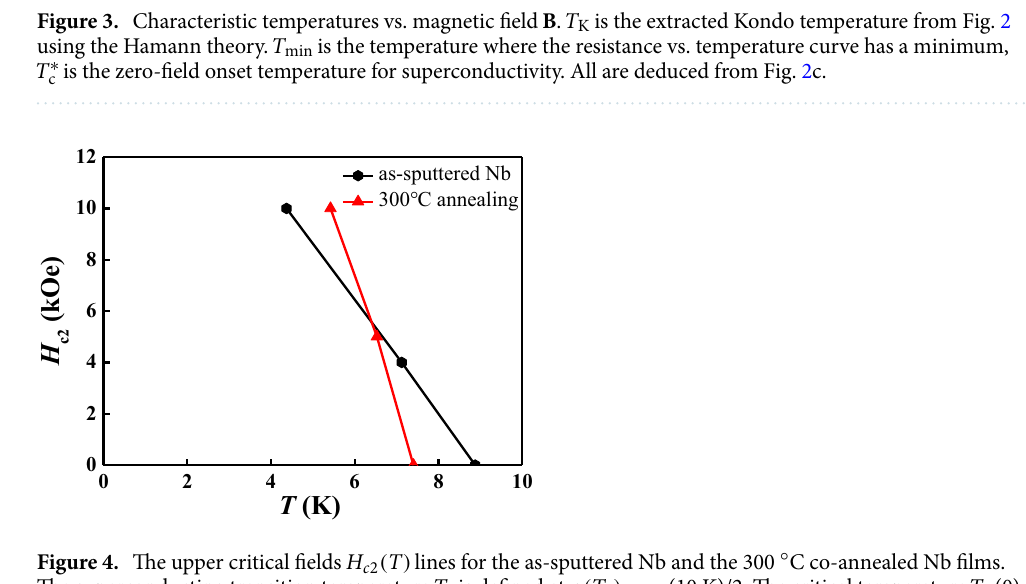
Figure 4. The upper critical fields H c 2 ( T ) lines for the as-sputtered Nb and the 300 ◦ C co-annealed Nb films. The superconducting transition temperature T c is defined at ρ( T c ) = ρ n (10 K)/2. The critical temperature T c (0) of the as-sputtered Nb film is 8.875 K, and the superconducting transition width is about 52 mK (10–90 % R n